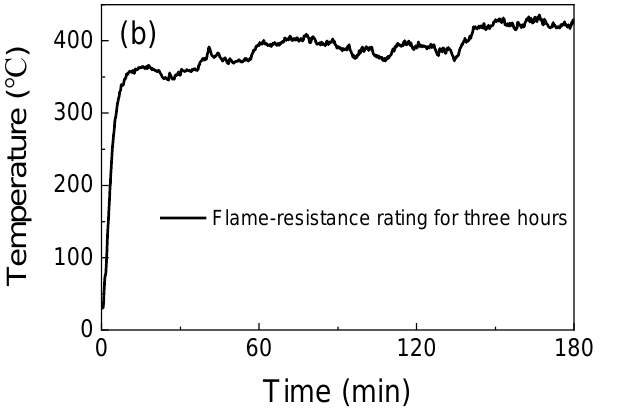
Figure 16. ( a ) Thermal analysis of the MKPCs before and after heating at 1000 °C, and ( b ) three hours of flame-resistance rating of the MKPC with the optimum compositions.